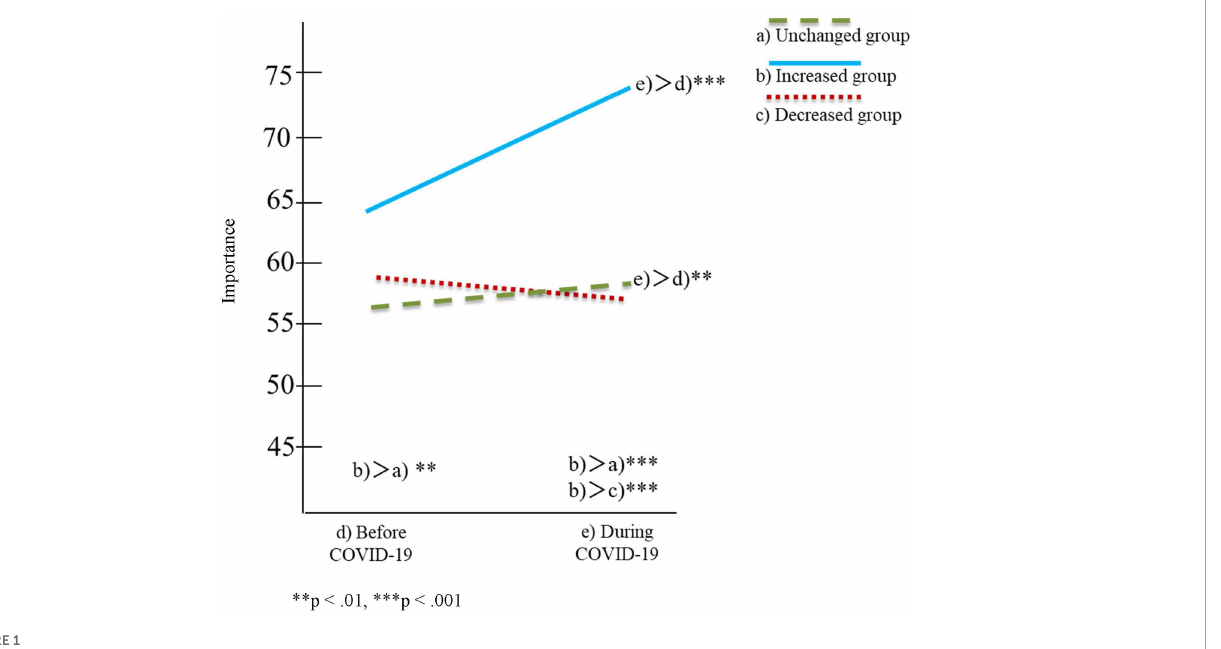
FIGURE1 Personal space for daily users.